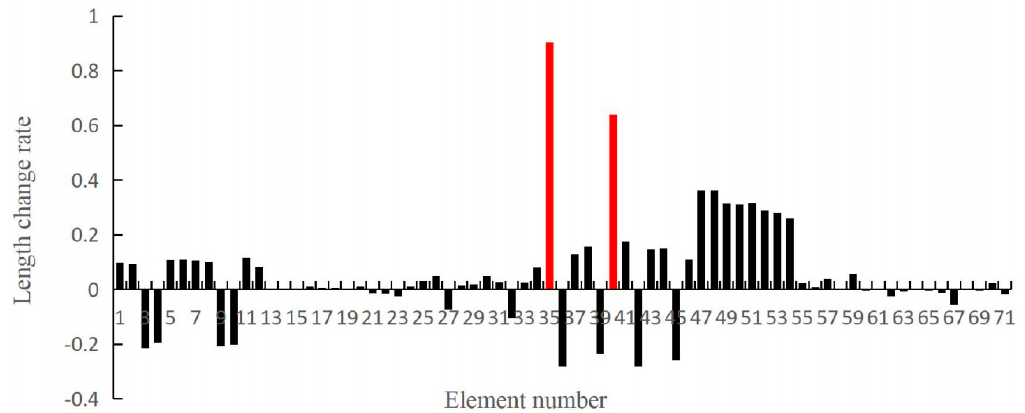
Figure 11. Length change rate of element obtained from the dynamic data (elements 35 and 40 were damaged adding 5% noise).